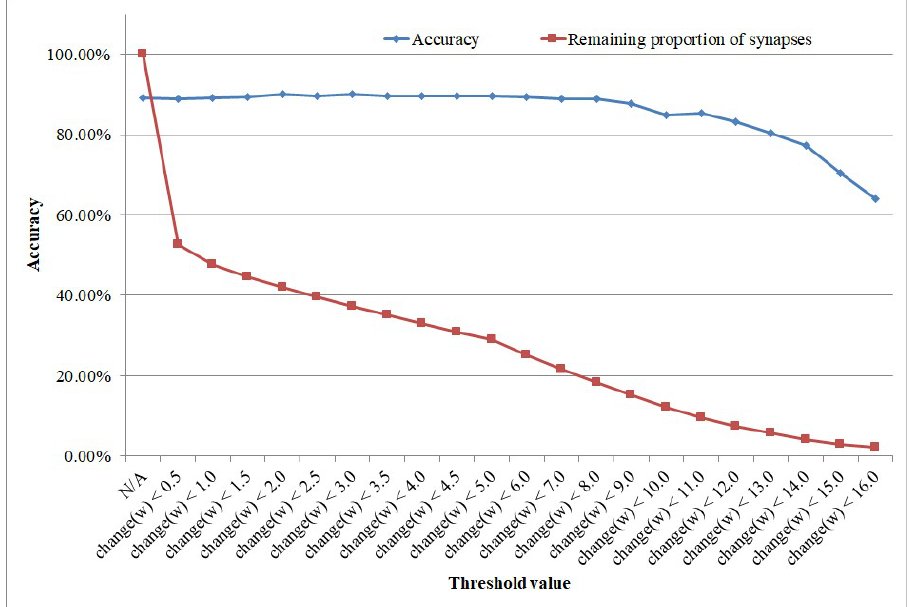
Figure 12. Influence of threshold value for structural